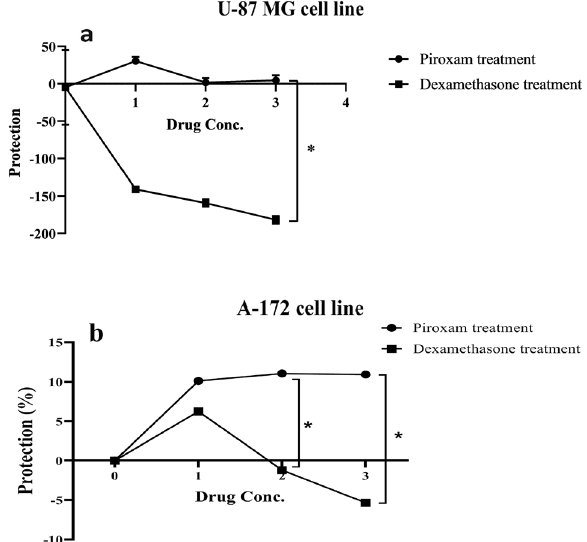
Figure 3. The effect of drugs on the protection of T cells in PBMCs co-cultured with U-87 MG and A-172 cell lines. The effect of three different concentrations of dexamethasone and piroxicam was determined on the protection of T cells in PBMCs cocultured with U-87 MG ( a ) (n = 3), and A-172 ( b ) (n = 4) cell lines. The graphs show the mean ± SD. Significant changes are indicated with asterisk (* p < 0.05, ** p < 0.01, *** p < 0.001, **** p < 0.0001).